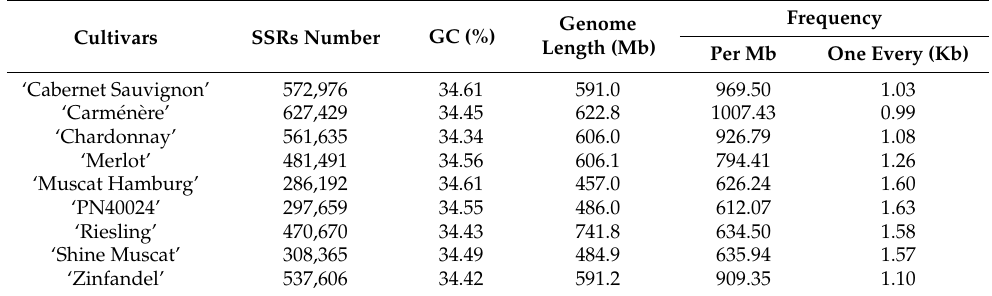
Table 1. Total frequency of SSRs in grape